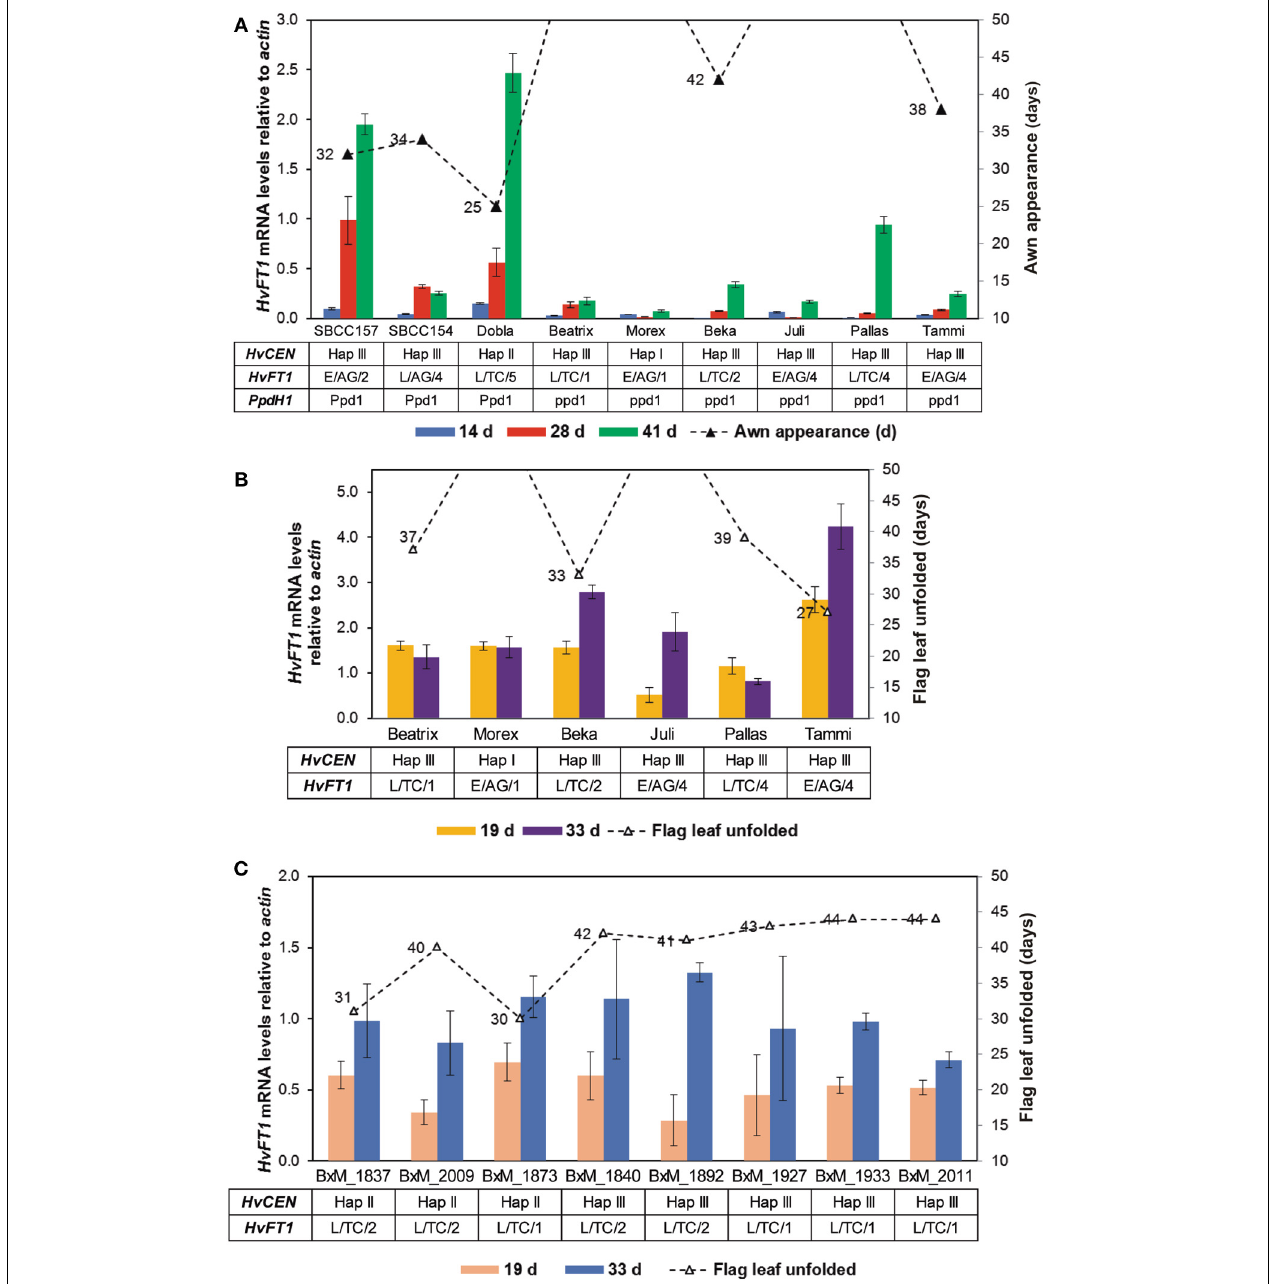
FIGURE 5 | HvFT1 expression analysis by qPCR. In a first experiment (A) , leaf tissue was harvested in the middle of the light period (after 8h light) 14, 28, or 41 days after sowing. Days until awn appearance (triangles) are shown for the whole duration of the experiment (50 days). HvCEN , HvFT1 , and PpdH1 haplotypes for each plant are also indicated. In the case of HvFT1 , polymorphisms for promoter (E, “early”; L, “late”), intron 1 (AG or TC) and copy number variation (for Table S1 for comparison. As observed for HvFT1 , our results